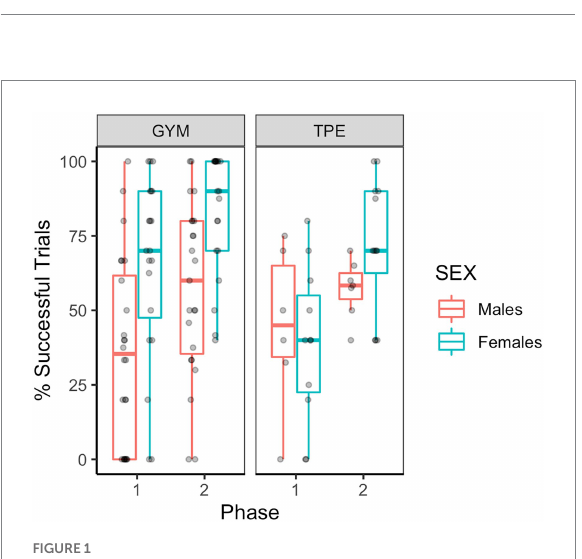
FIGURE 1 Successful trials (%) for males and females in the GYM and TPE